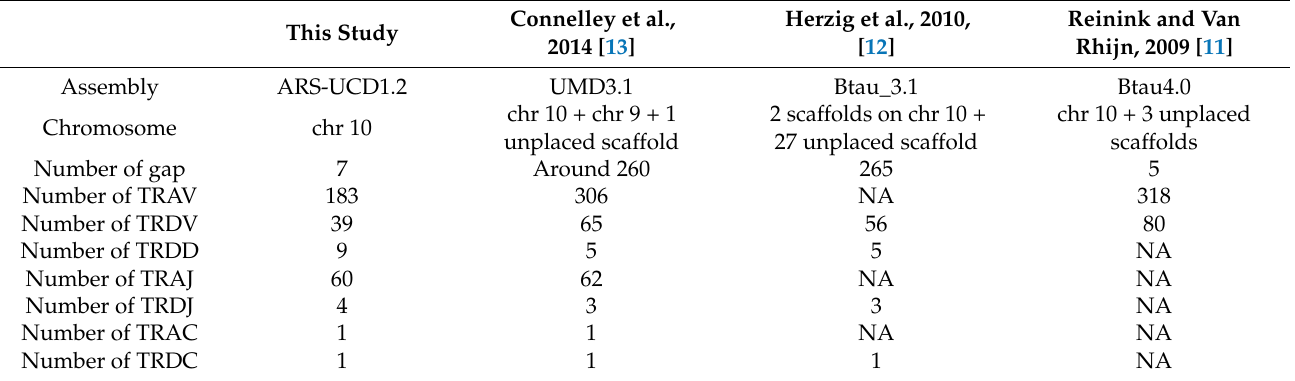
Table 2. Comparison of the different studies of TRA/TRD loci in bovine ( Bos taurus ). This Study